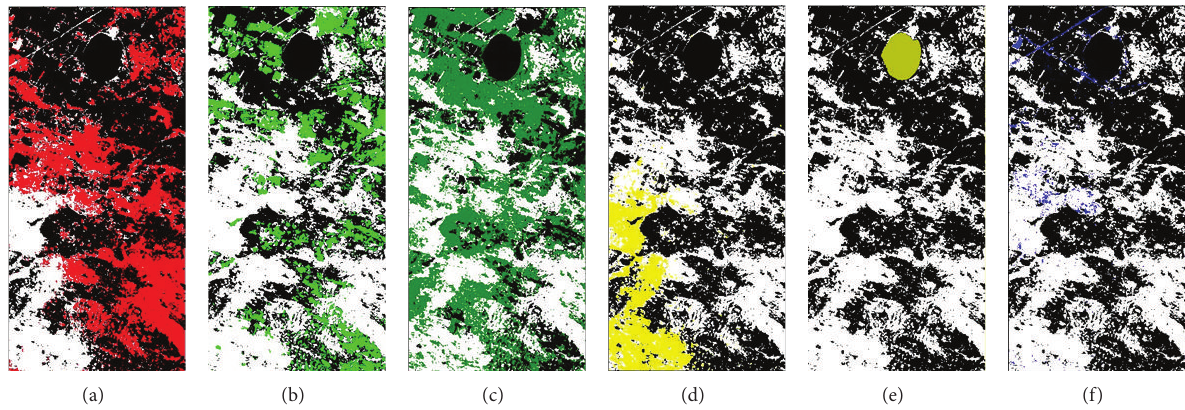
Figure 6: The thematic maps of a variety of categories of surface features in study area. (a) The thematic maps of barren vegetated. (b) The thematic maps of croplands. (c) The thematic maps of grasslands. (d) The thematic maps of wilderness. (e) The thematic maps of water. (f)The thematic maps of